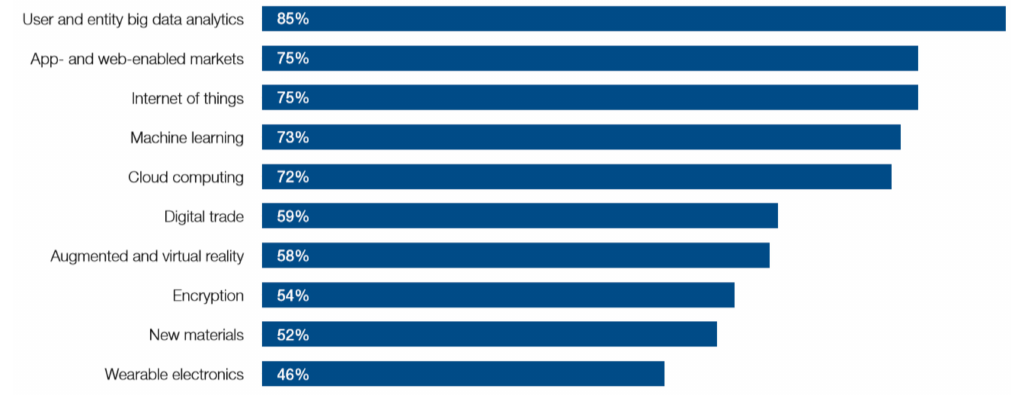
Figure 2. Top Ten Future Jobs—World Economic Forum